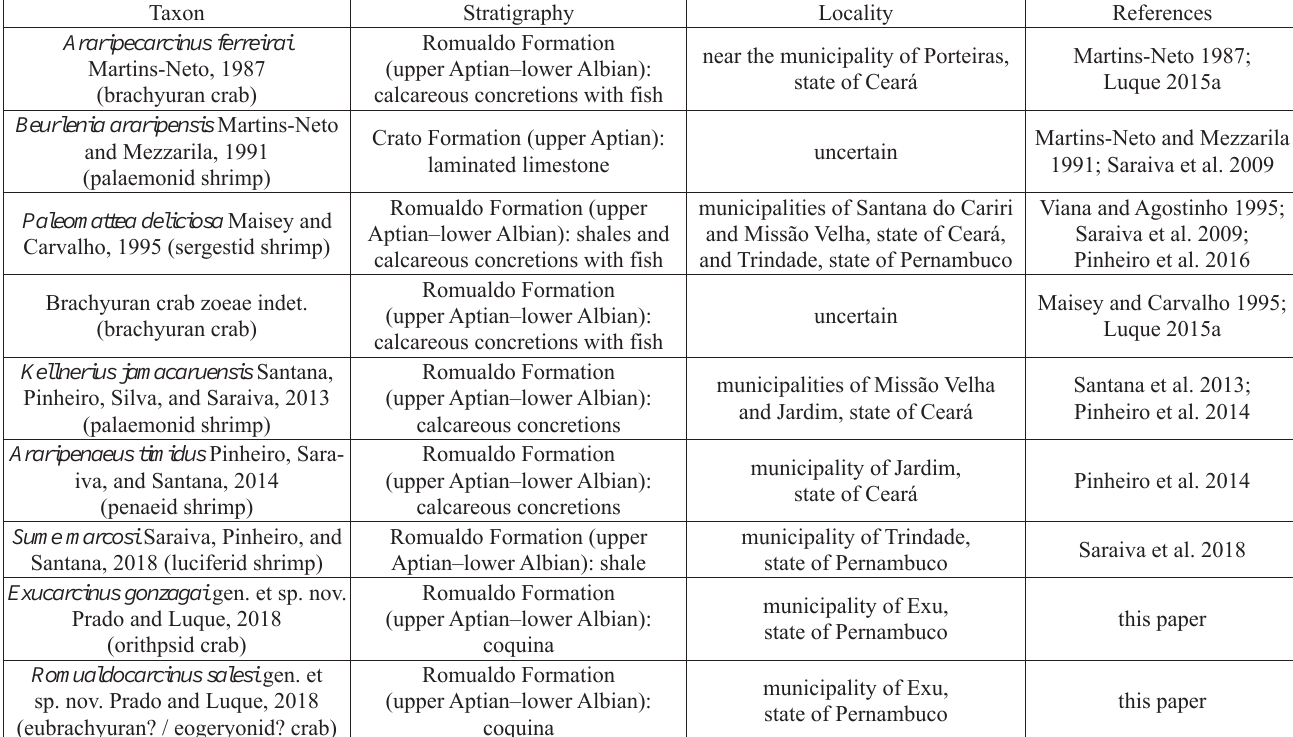
Table 1. List of decapods described from the Santana Group in the Araripe Basin.